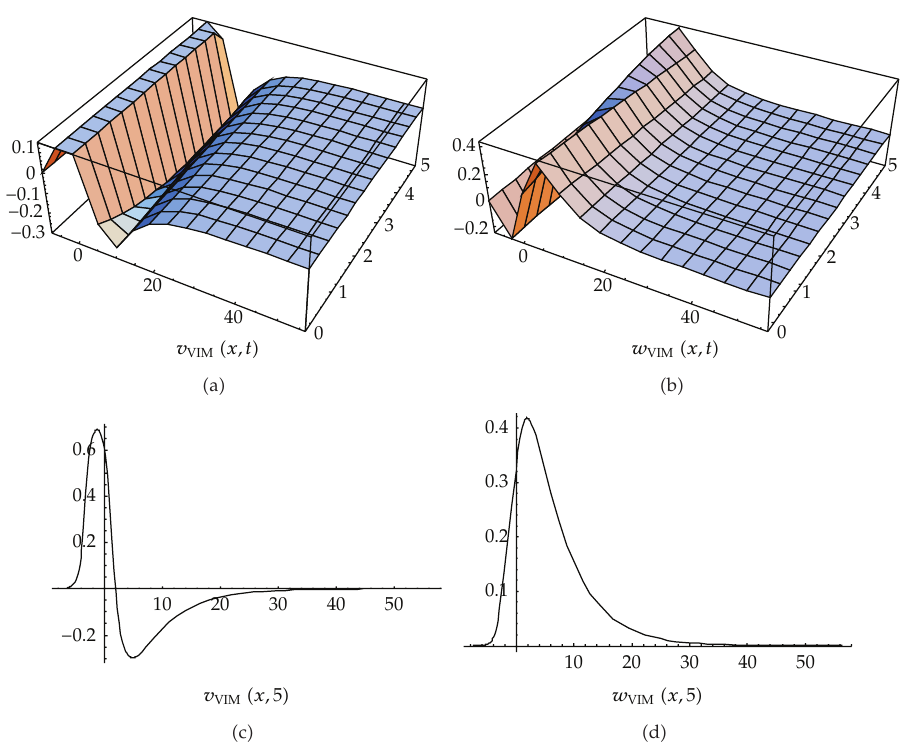
Figure 1: The approximated solutions for v (cid:2) x,t (cid:3) , w (cid:2) x,t (cid:3) at time T (cid:8) 5.